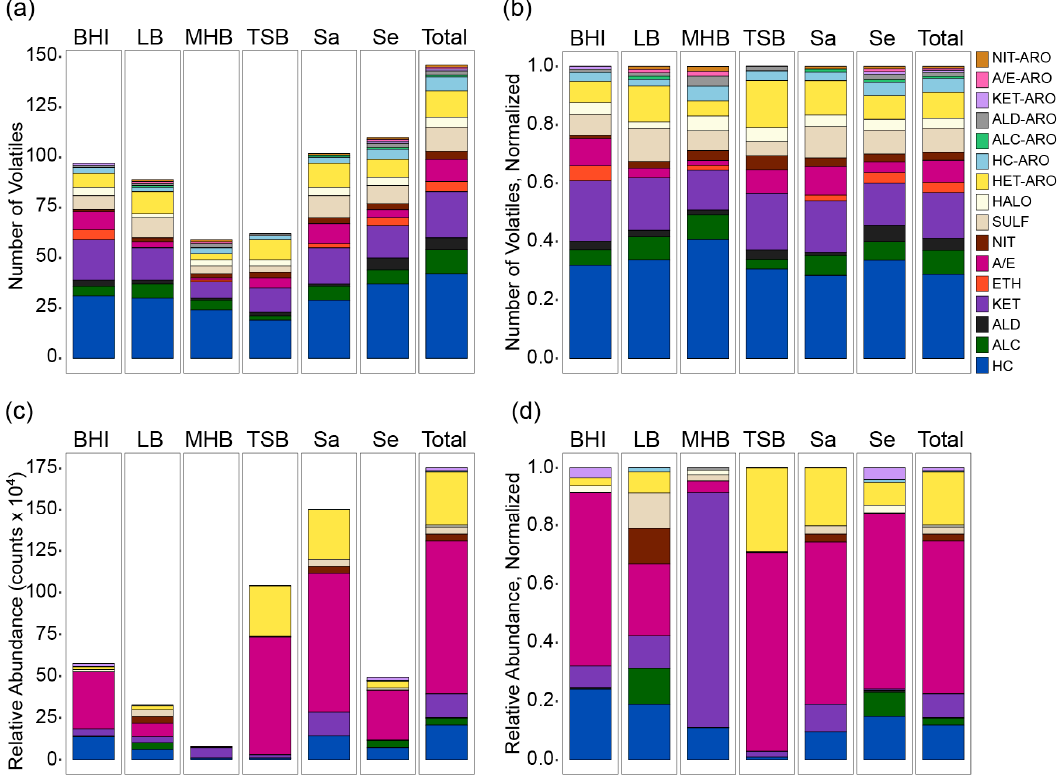
Figure 1. Chemical composition of the total staph volatilome (Total), and the volatilome by species ( S. aureus , Sa, or S. epidermidis , Se) or by growth medium (brain heart infusion (BHI), tryptic soy broth (TSB), Mueller Hinton broth (MHB), lysogeny broth (LB)). The data are presented as the total number of volatiles detected in each chemical class, unnormalized ( a ) and normalized ( b ), and the total relative abundances of volatiles in each chemical class, unnormalized ( c ) and normalized ( d ). Level 4 (unknown) compounds were excluded. Each column represents composite data, with the media volatilomes representing the data for both species, the species volatilomes representing the volatilomes of that species in all four media, and the total representing the volatilomes of both species in all four media. The numerical data are provided in Tables S2–S5. HC, hydrocarbons; ALC, alcohols; ALD, aldehydes; KET, ketones; ETH, ethers; A/E, acids and esters; NIT, nitrogen-containing; SULF, sulfur-containing; HALO, halogen-containing; HET-ARO, heteroaromatics; HC-ARO, aromatic hydrocarbons; ALC-ARO, aromatic alcohols; ALD-ARO, aromatic aldehydes; KET-ARO, aromatic ketones; A/E-ARO, aromatic acids and esters; NIT-ARO, aromatic nitrogen-containing.